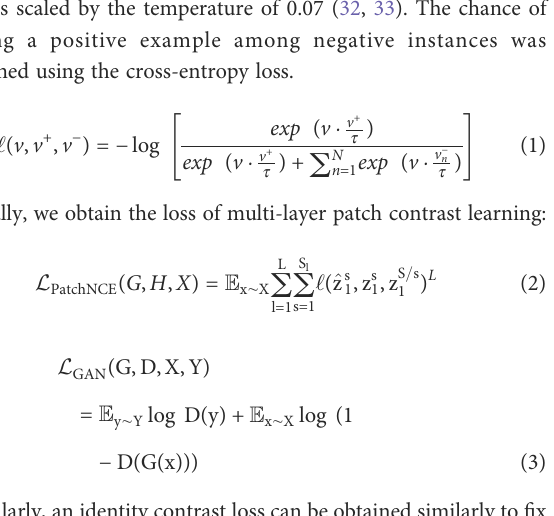
Figure 3 compared the target segmentation performance between the fi xed image using the CBCT image and sCT image. The red, blue, and green contours represent the target area on the I wCBCT image and I wsCT image. After using sCT images for fi xed image alignment, the target contours are better than the original CBCT images for fi xed